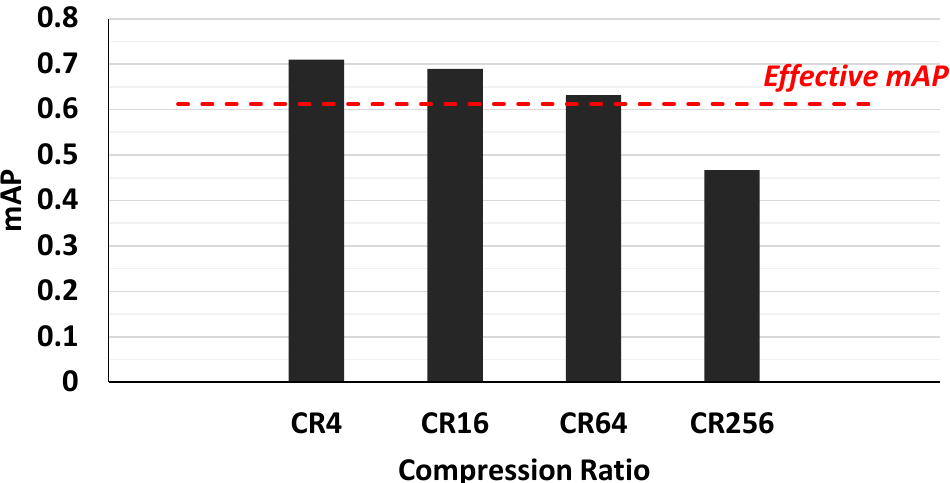
Figure 7. Auto-tiler with compression ratio (CR) of 4–256 and its respective